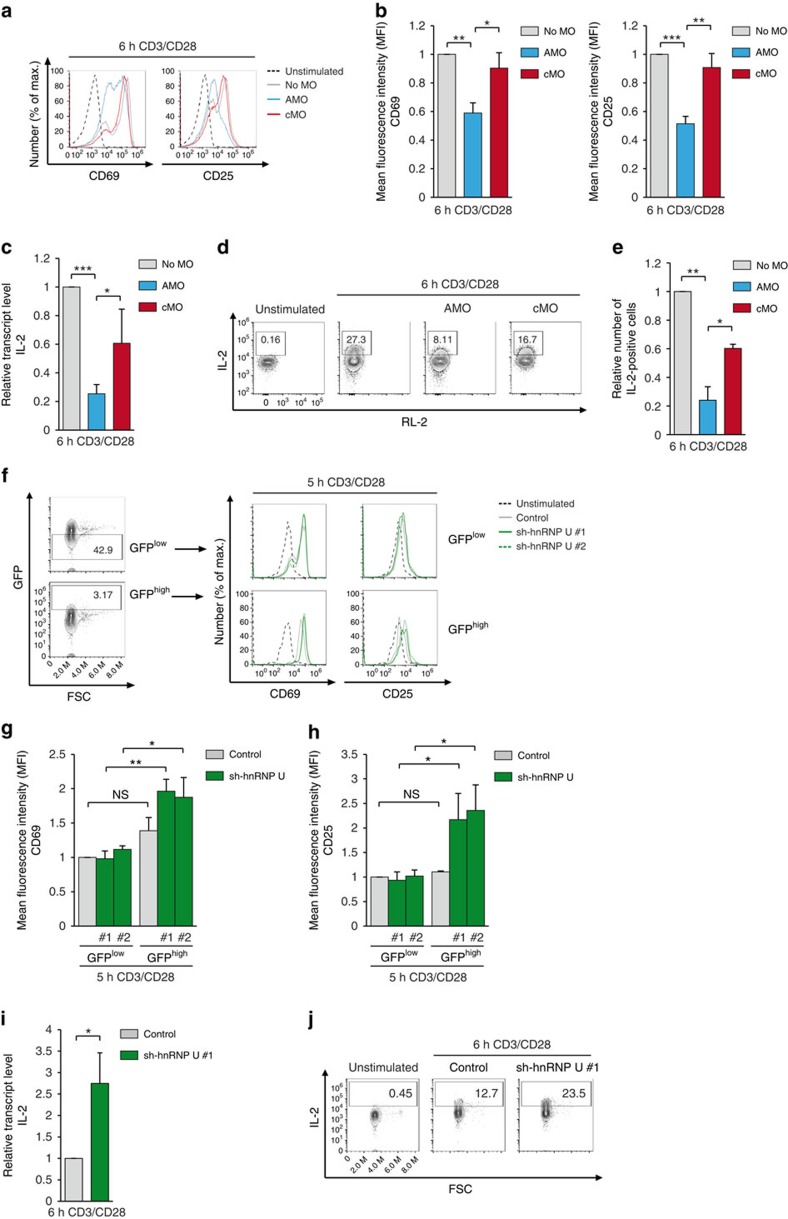
MALT1A induction and hnRNP U downregulation augment T-cell activation.(a–e) CD4+ T cells from BALB/c mice were left untreated or were treated with AMO or cMO before stimulation. (a) Cell surface expression of CD69 and CD25 was determined by FACS after 6 h of anti-CD3/CD28 stimulation. (b) Mean fluorescence intensity (MFI) values of CD25 and CD69 after stimulation of MO-treated cells. (c) Induction of IL-2 mRNA in CD4+ T cell (no MO, AMO or cMO treated) after anti-CD3/CD28 stimulation was determined by qPCR. (d) Intracellular IL-2 staining after anti-CD3/CD28 and different MO treatments was analysed by FACS. (e) Number of IL-2-positive cells as gated in d was quantified in relation to stimulated control cells (no MO). (f–j) CD4+ T cells from R26/CAG-CARΔ1stop-flCd4-Cre mice were transduced with control or sh-hnRNP U adenoviruses and stimulated with anti-CD3/CD28. (f) Cells gated for GFPlow and GFPhigh expression (left) were analysed for CD25 and CD69 surface expression (right). (g,h) CD25 and CD69 MFI values after stimulation of adenoviral-transduced cells. MFI was directly compared between GFPlow (no hnRNP U knockdown)- and GFPhigh (hnRNP U knockdown)-expressing cells. (i) Relative IL-2 mRNA levels in sorted GFP+ CD4+ T cell on adenoviral transduction of control or sh-hnRNP U #1 after anti-CD3/CD28 stimulation was determined by qPCR. (j) Intracellular IL-2 levels after anti-CD3/CD28 stimulation in sorted GFP+ cells was analysed by FACS. Histograms and dot blots show representatives of two (j) or three (a–i) independent experiments. (b,c,e,g–i) Depicted is the mean±s.d. (n=3). *P<0.05; **P<0.01; ***P<0.001; NS, not significant; unpaired t-test.